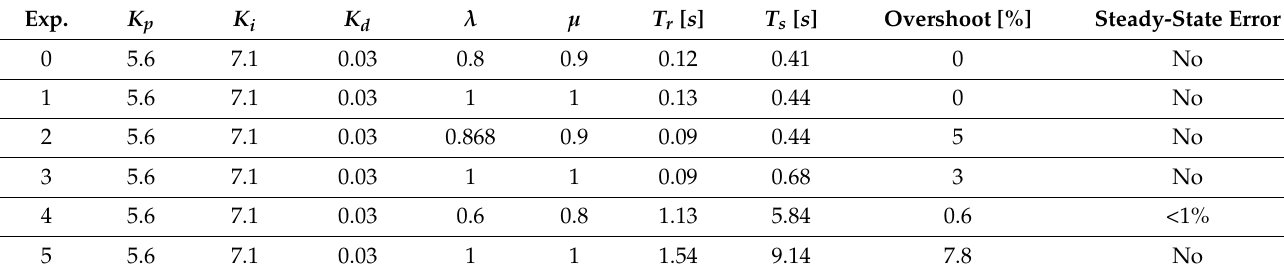
Table 6. Comparison of step responses with PID and PI λ D µ control in different